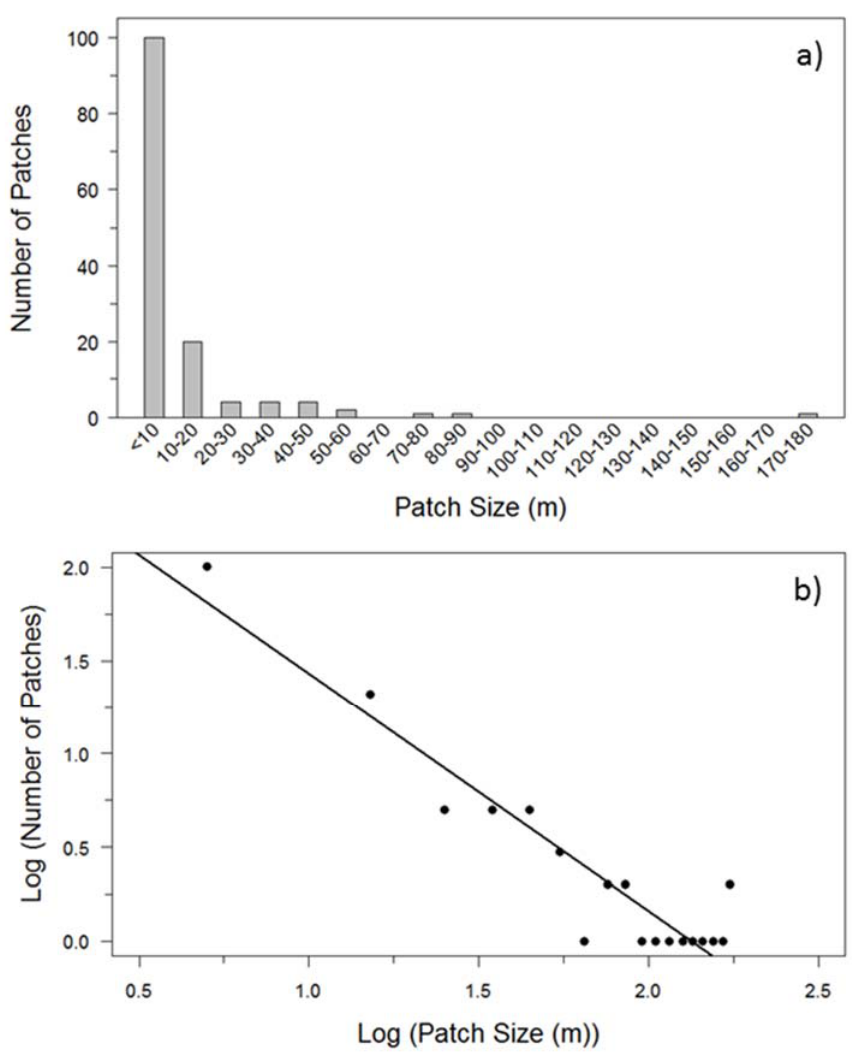
Figure 2. ( a ) Frequency distribution of buffaloberry shrub patch sizes (m) among transects based on line ‐ intercept sampling; and ( b ) the log 10 ‐ transformed frequency distribution of buffaloberry patch sizes, where midpoints of each size range were used to calculate transformed values ( R 2 = 0.88; β = − 1.269; p < 0.001).